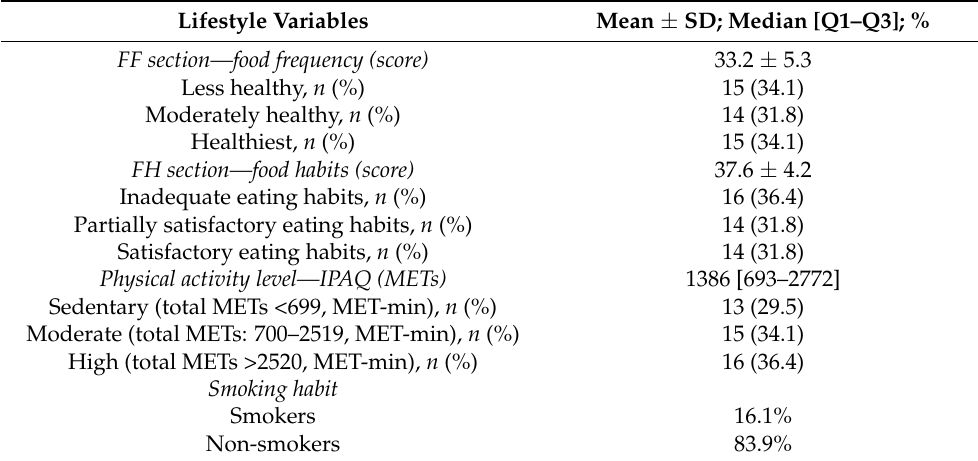
Table 3. Lifestyle habits. Data were reported as mean ± standard deviation (SD), median and interquartile range [Q1–Q3] or frequency of subjects expressed as number (n) and percentage (%).